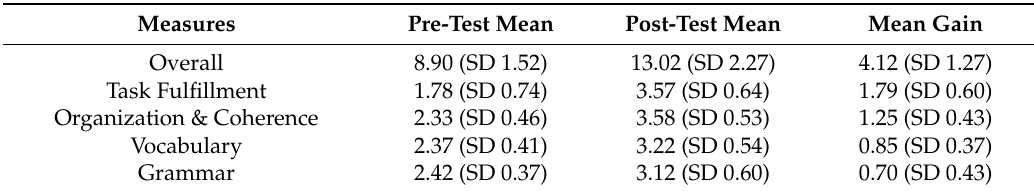
Table 2. Control group ( n = 30) overall and component pre-test to post-test mean scores, mean gain scores, and standard